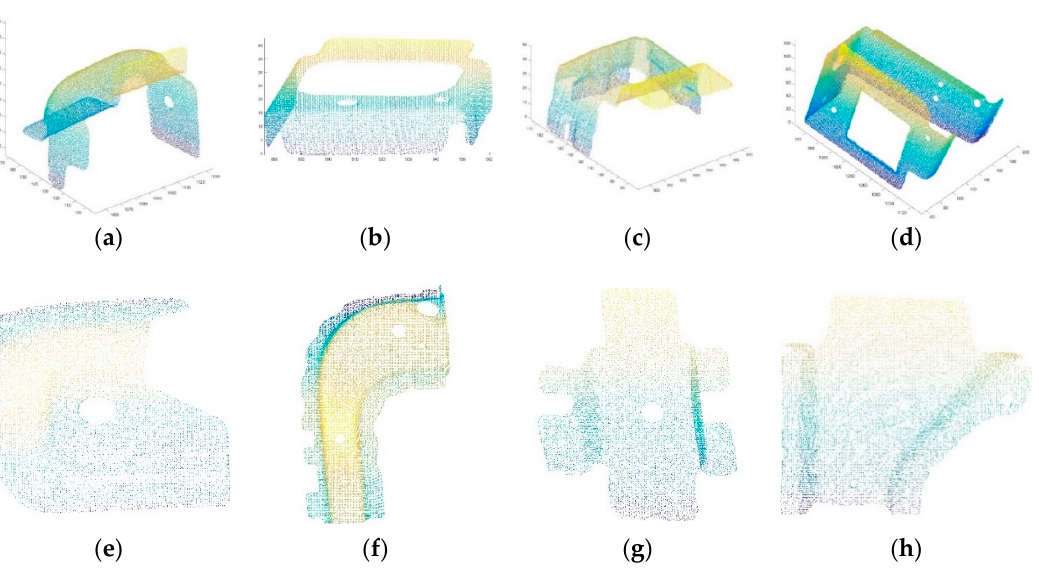
Figure 10. PCD after simplification in Figure 9. ( a )–( h ) are a series of simplification results of vehicle body parts PCD in Figure 9, respectively.